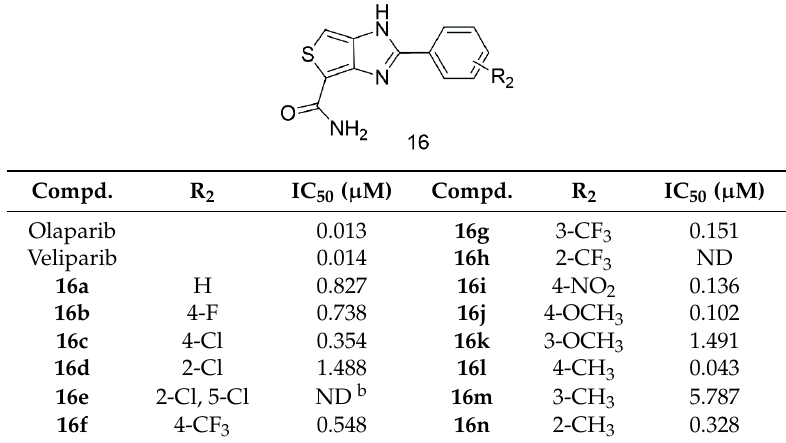
Table 2. The structures and PARP-1 enzyme inhibitory activity of compounds 16a – n . a